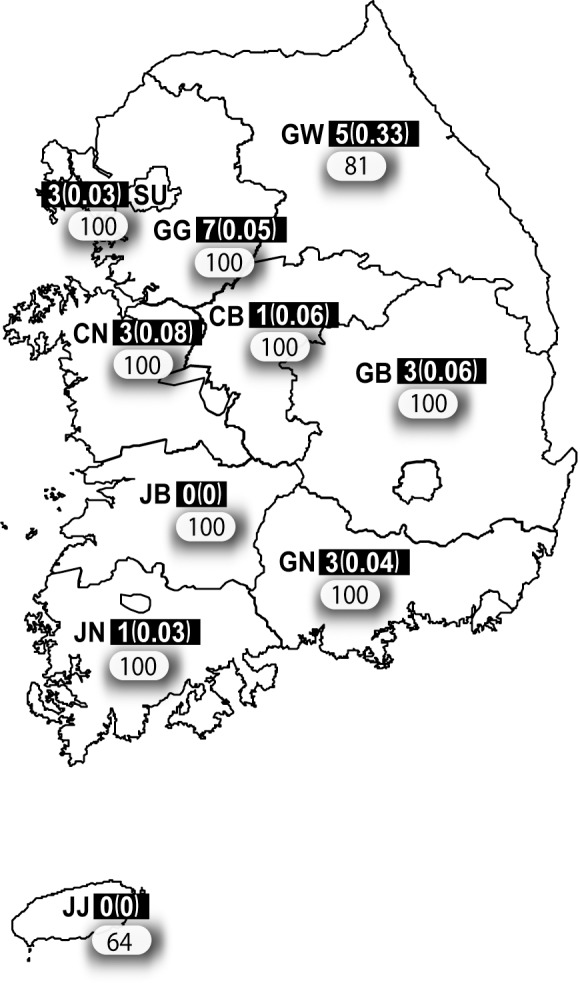
Study areas and distribution of study subjects.Human serum samples were obtained from the National Biobank of Korea. Using simple random sampling, 945 subjects were selected within four age groups from 10 provinces. The number of subjects per area is provided in the rounded rectangle. The number of patients with Japanese encephalitis in 2010 is provided in the black squares. In addition, the incidence rates per 100,000 persons in each province are provided in parenthesis. SU, Seoul; GG, Gyeonggi; CB, Chungbuk; CN, Chungnam; JB, Jeonbuk; JN, Jeonnam; GN, Gyeongnam; GB, Gyeongbuk; GW, Gangwon; JJ, Jeju.